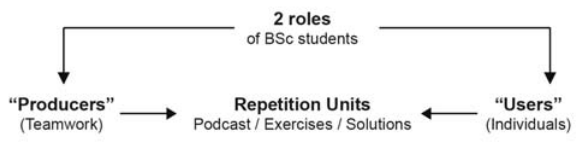
Figure 2. Roles of BSc.-Students within